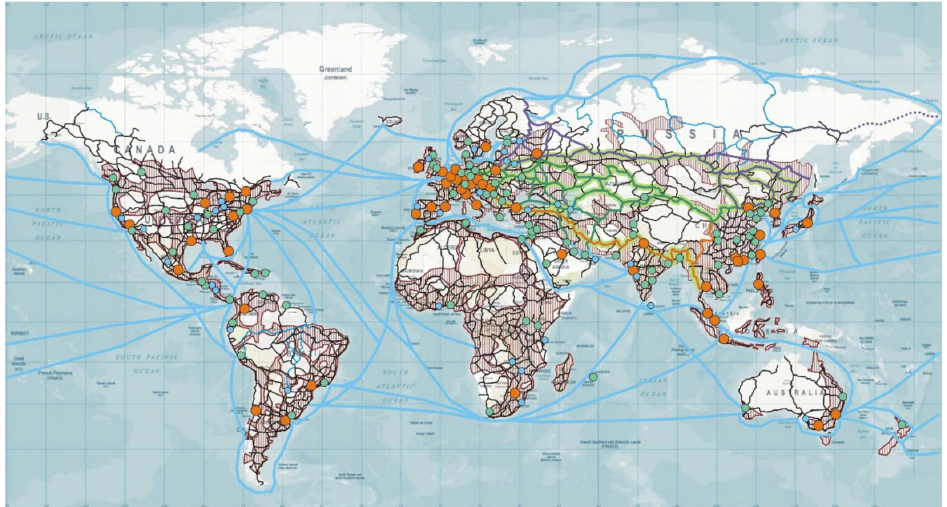
Figure 11. A model of the relationship of Eurasian transcontinental links in the world transport system, world cities according to GaWC and the ecumenopolis system according to K.